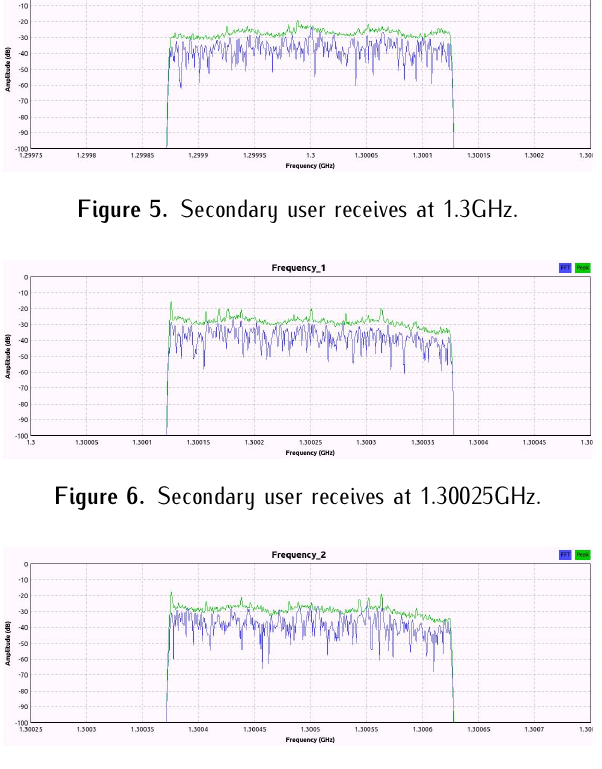
Figure 7. Secondary user receives at